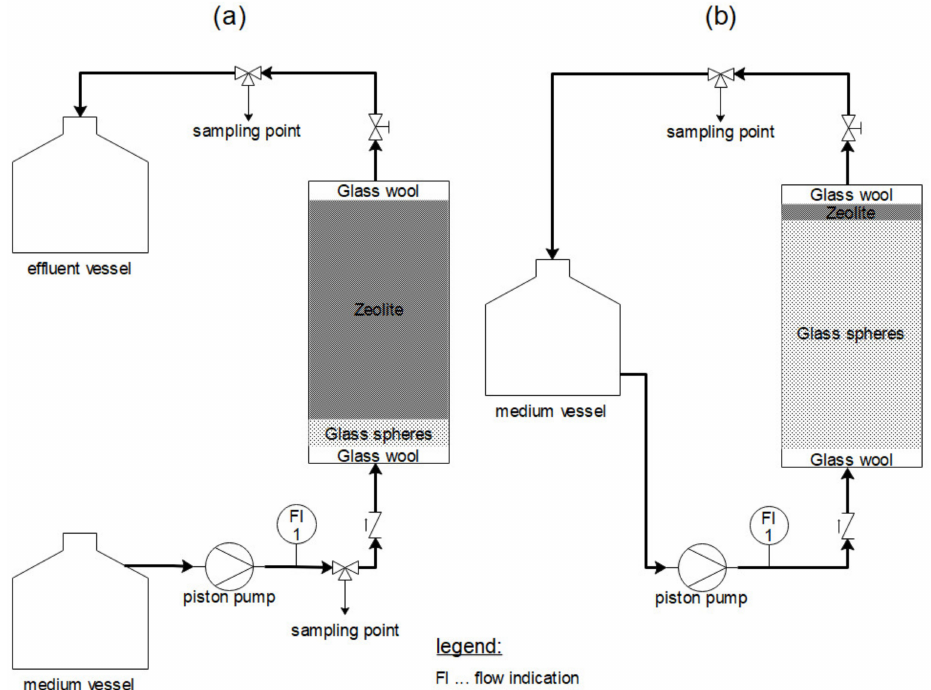
Figure 5. Flowcharts of the continuous flow through fixed-bed column ( a ) and differential circuit batch reactor ( b ) used in this